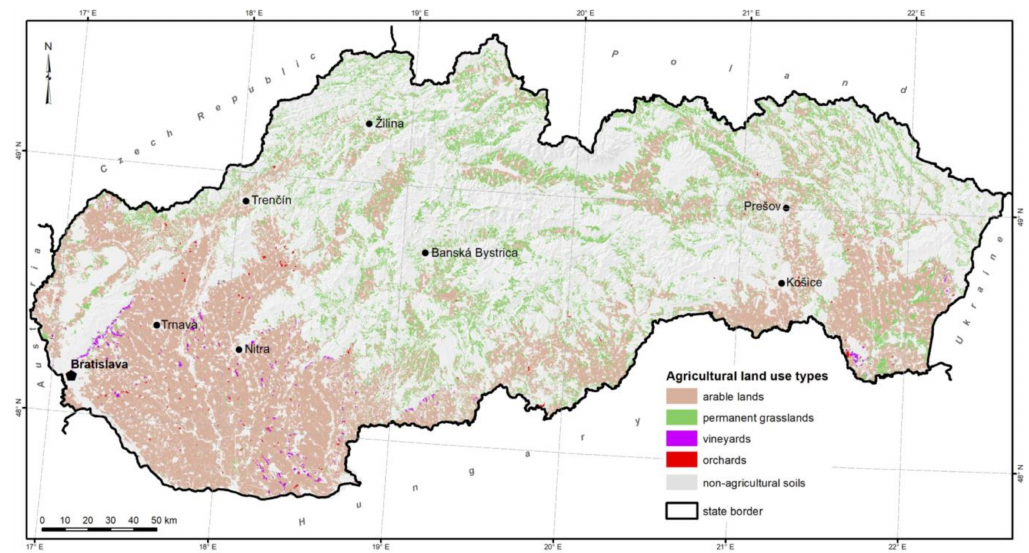
Figure 2. Spatial identification of agricultural land use types in Slovakia